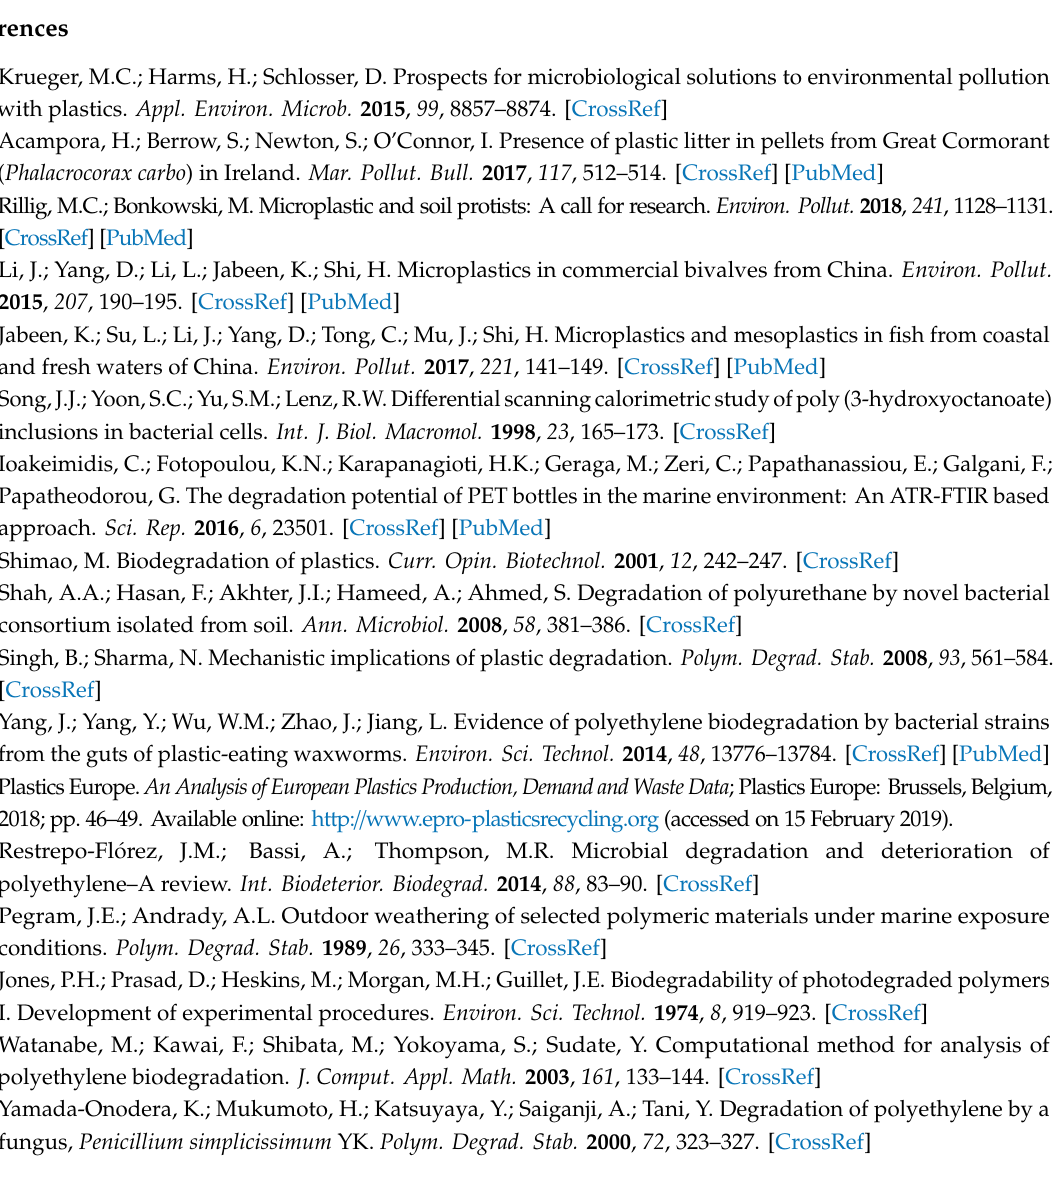
Figure S1: The changes of OD 600 of the four strains during the 31-day cultivation. The four strains were screened from the gut homogenate of the wax moth that could grow in the LPEM containing 5% PE, Table S1: The estimated OD 600 of every sample during the 31-day cultivation, Table S2: Statistical summary of the atom C and O on the surface of PE film, Table S3: Independent samples test for the atomic percentage of every sample, Table S4: Detection of the significantly increased compounds from the bacterial solution of the D1 group compared with the control group by LC-MS at the end of the 31-day